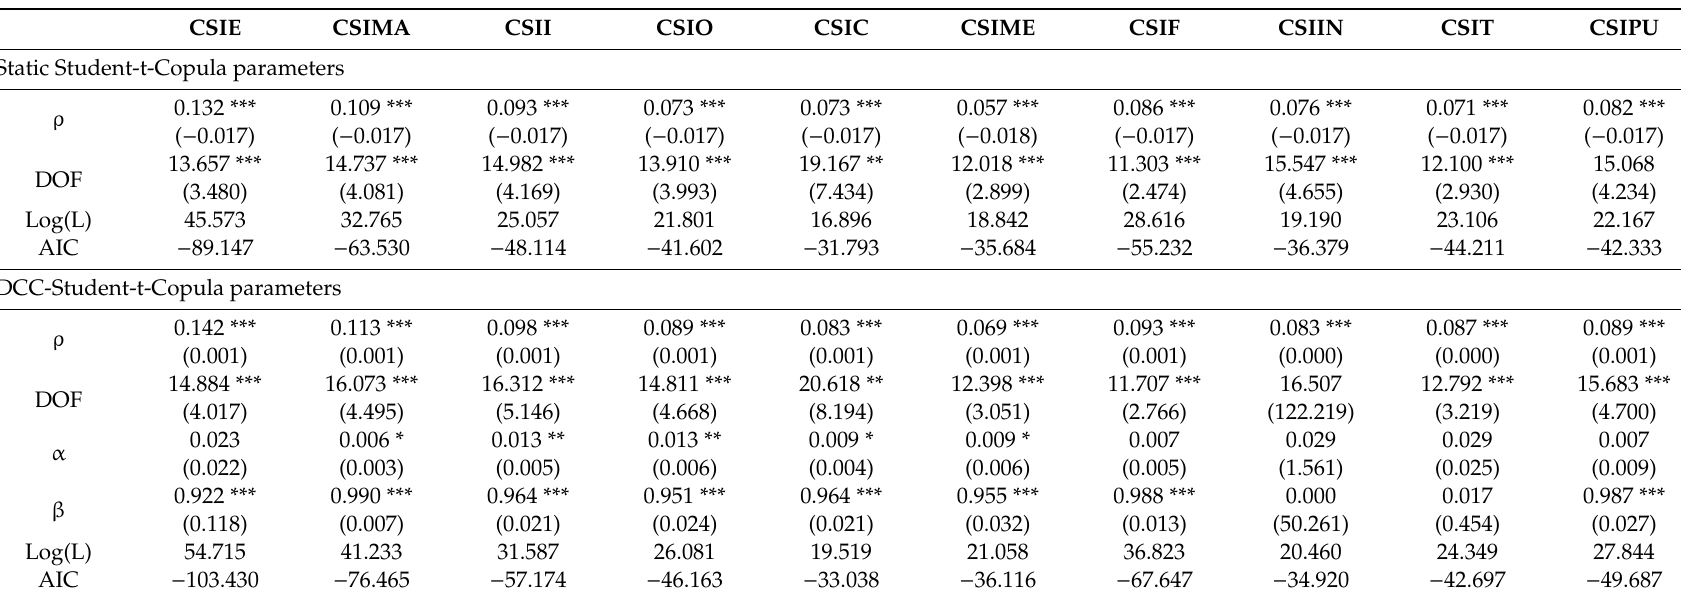
Table 4. Estimates of t-Copula for original returns series between Brent spot price and the stock indexes of China Securities